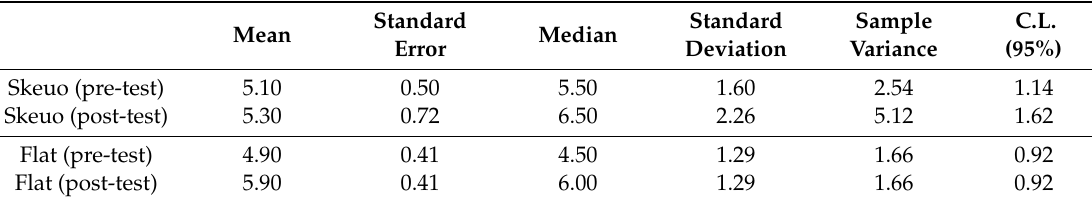
Table 18. Expectation (pre-test) and experience (post-test) ratings on scenario execution difficulty. Standard Standard Sample Mean Median Error Deviation Skeuo (pre-test)